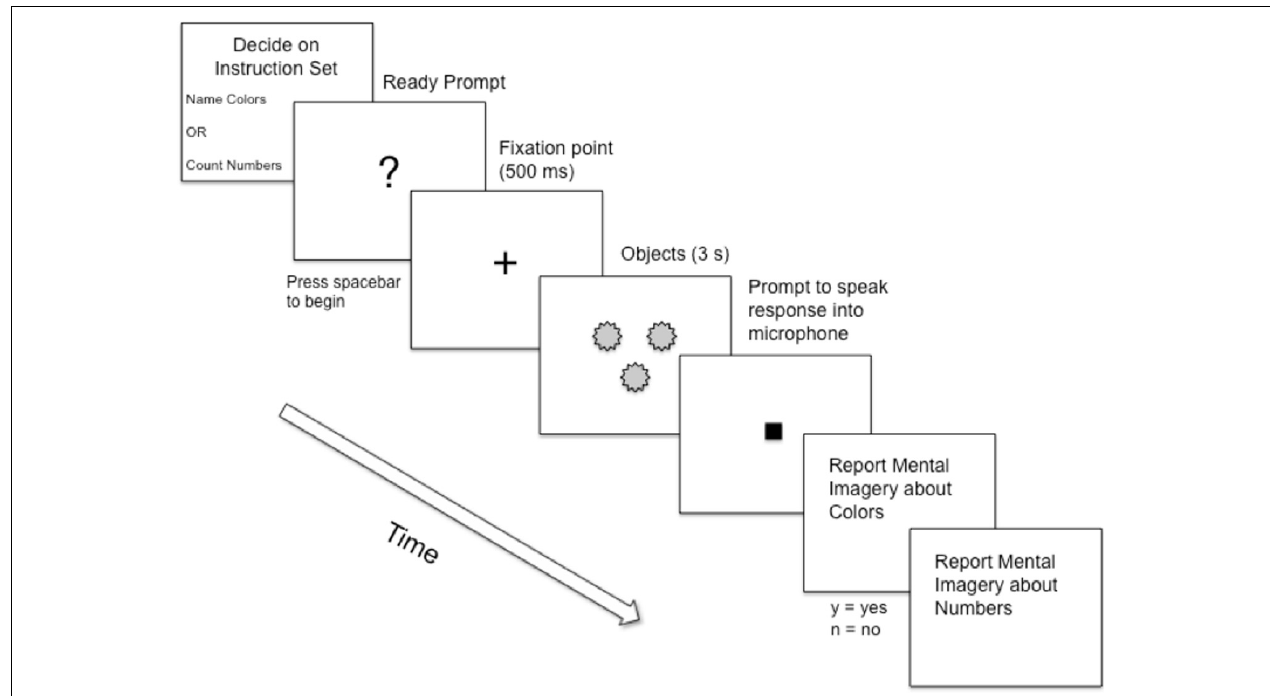
FIGURE 4 | Schematic depiction of a typical trial (Experiment 1B). Not drawn to